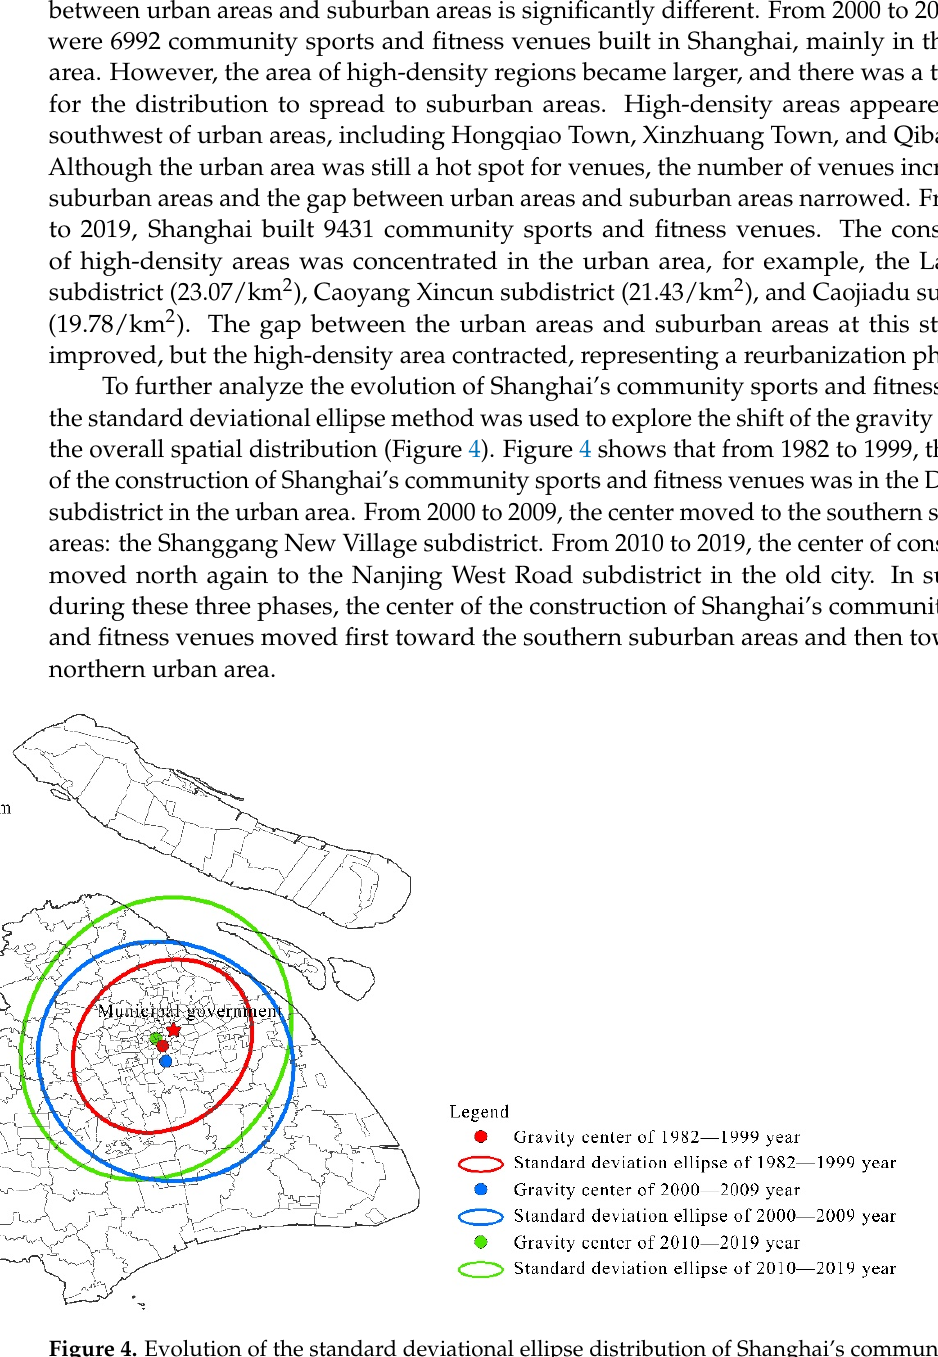
Figure 4. Evolution of the standard deviational ellipse distribution of Shanghai’s community sports and fitness venues.